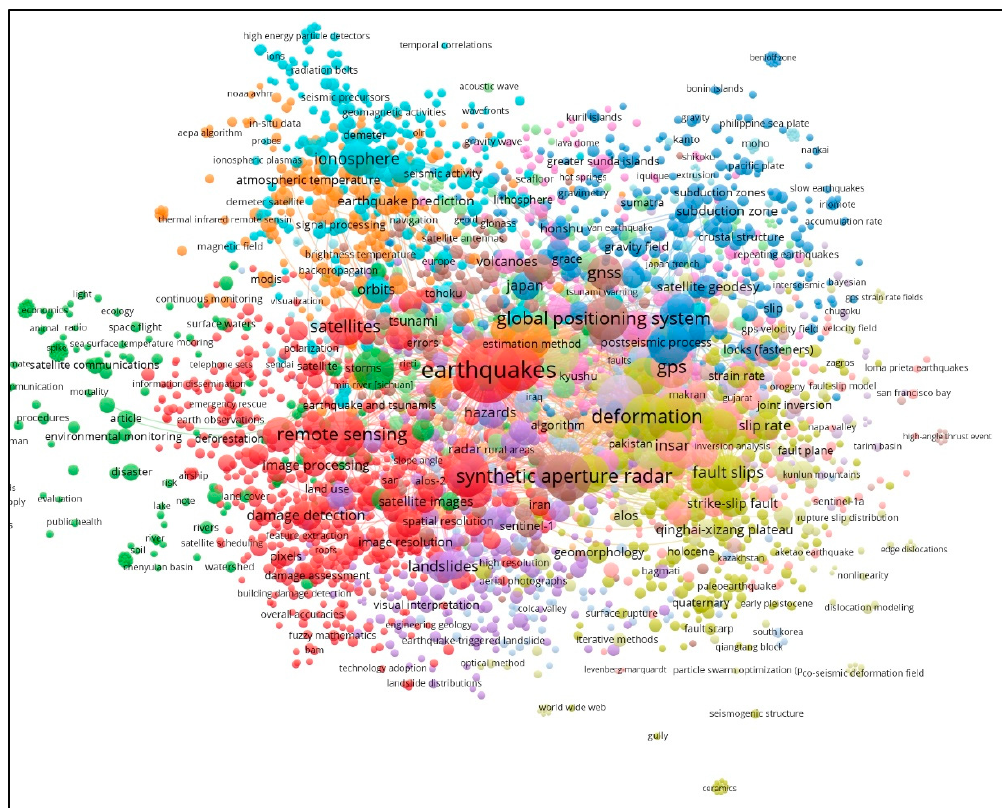
Figure 2. Visualization of the scientific studies related to earthquakes and satellite observations affecting cultural heritage. The database was extracted from the Scopus engine and visualized in the VOSviewer software.